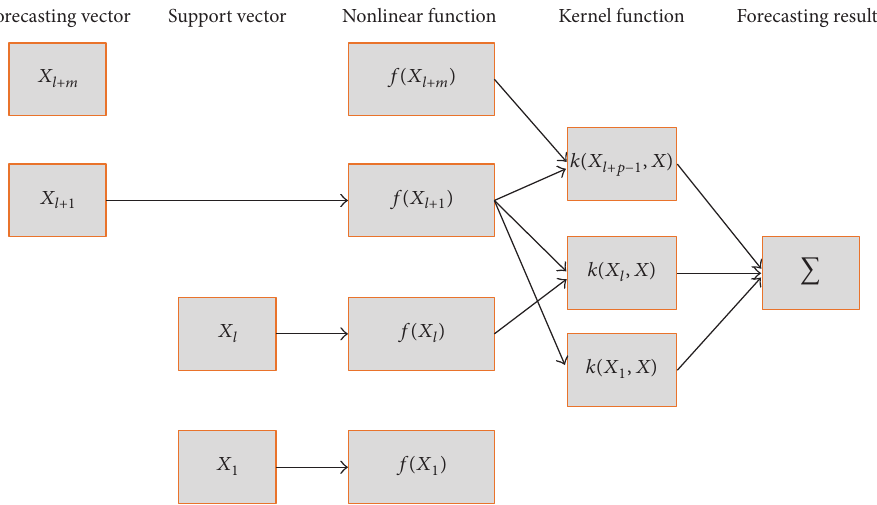
Figure 1: LSSVR structure for river flow